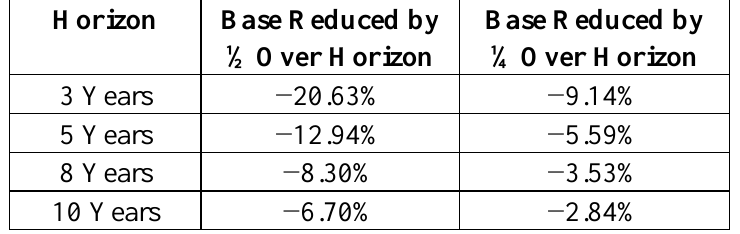
Table 8. Annualized Reduction Rates of Monetary Base Over Various Horizons 1